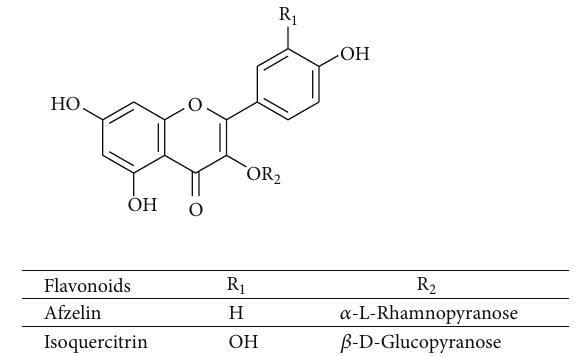
Figure 4: Kaempferol 3- O - 𝛼 -L-rhamnopyranoside (afzelin- Acet32), quercetin 3- O - 𝛽 -D-glucopyranoside (isoquercitrin-